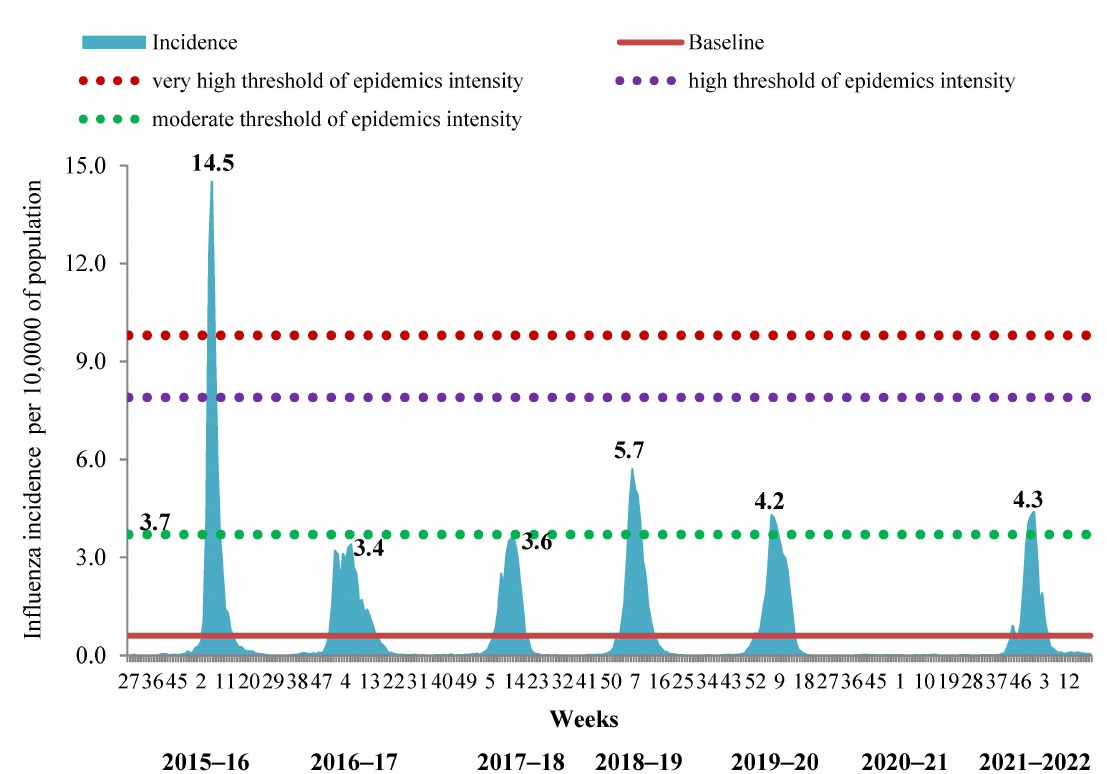
Figure 3. Assessment of the duration and intensity of influenza epidemics according to the incidence of clinically diagnosed influenza for the period from 2015 to 2022.